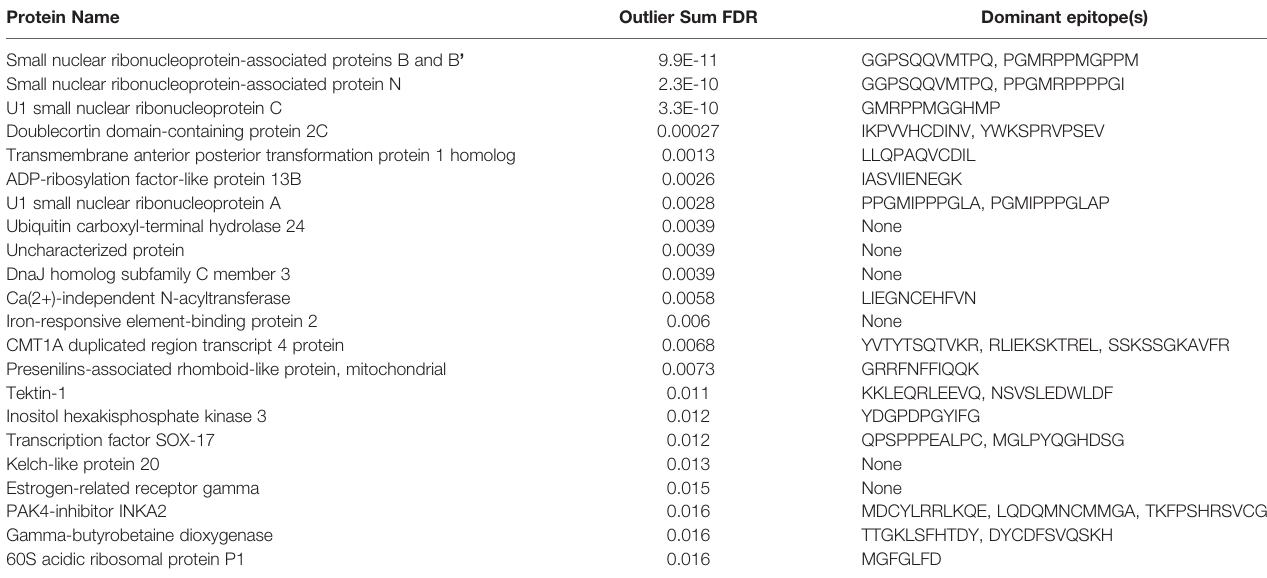
TABLE 1 | Dominant epitopes for highest scoring antigens from SLE PIWAS. Protein Name